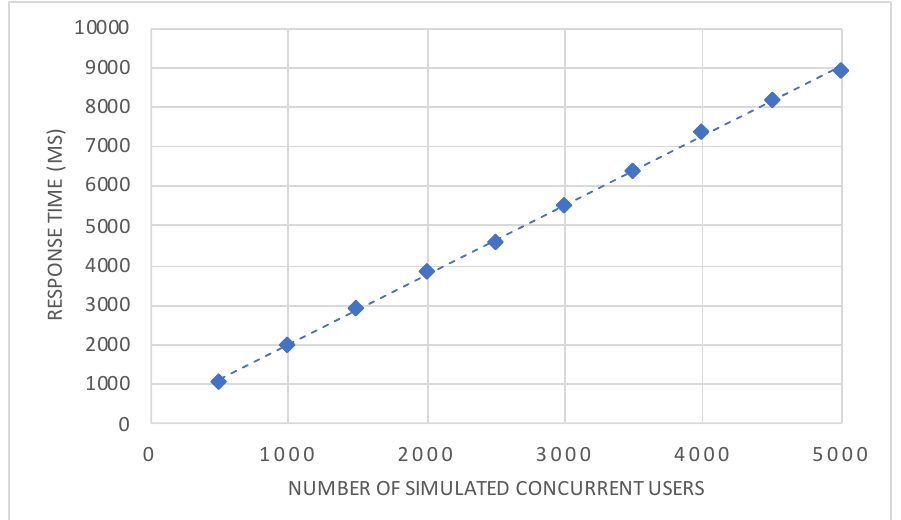
Figure 11. Median of the response time measurements for different numbers of simulated concurrent (simultaneous) users. The dashed line represents an ideal linear trend line. All experiments were repeated 20 times and the confidence intervals (CI) at confidence level 0.95 (1 − α = 0.959) were within 5% of the respective